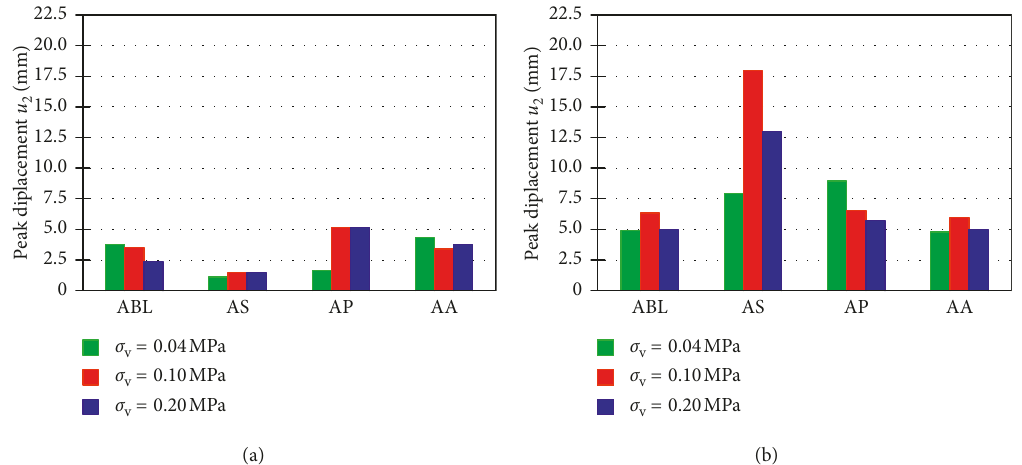
Figure 25: The effect of vertical contact stress below the foundation on peak horizontal displacement u